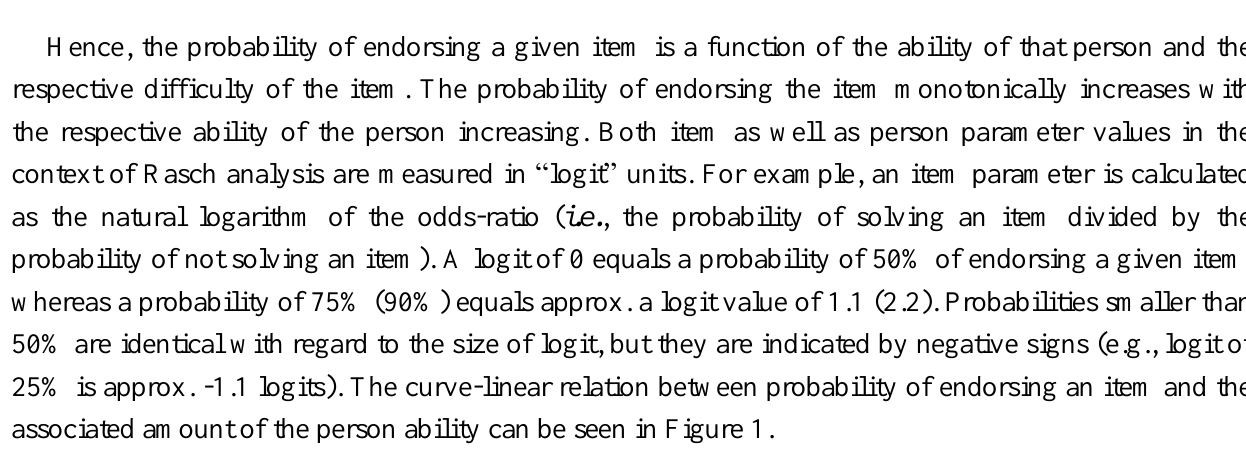
Table 1. Item difficulties sorted by item hierarchy (easy and difficult